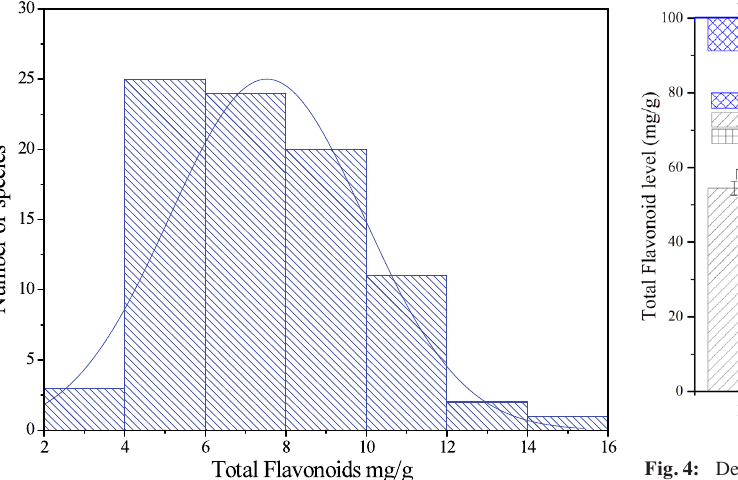
Fig. 3: Distribution diagram for the total flavonoid content in mulberry leaves